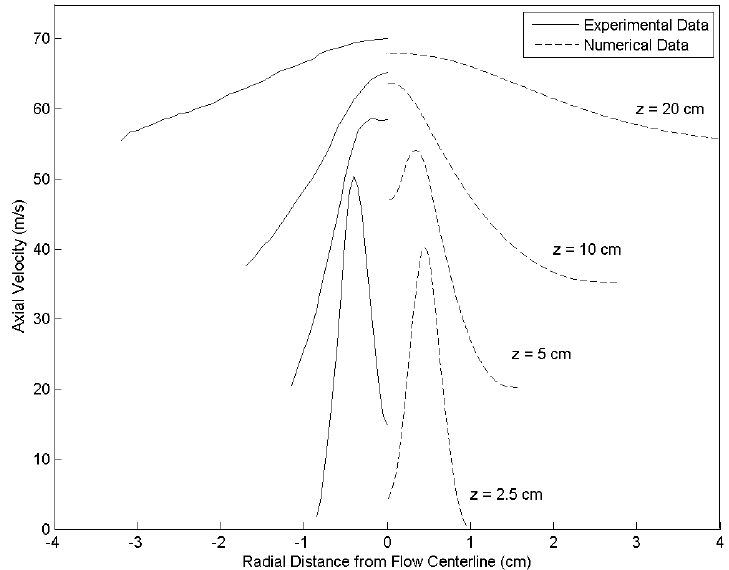
Figure 19. Experiment 1: Comparison of offset experimental and numerical axial velocity profiles at 2.5 cm, 5 cm, 10 cm and 20 cm from the annular air